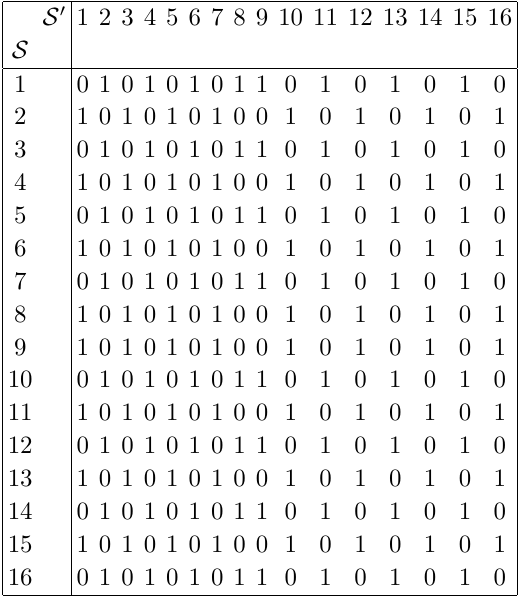
(cid:2) P with di(cid:11)erent boolean factors. [5] [6]